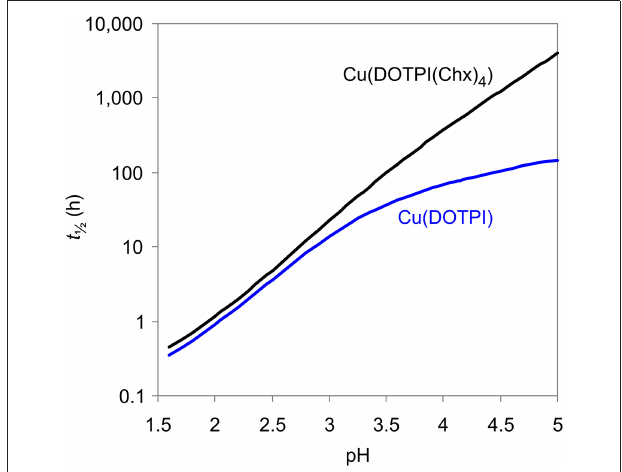
FIGURE 4 | Dissociation half lives ( t ½ = ln2/ k d ) of Cu(DOTPI) and Cu(DOTPI(Chx) 4 ) as functions of pH (25 ◦ C, 0.15M NaCl).